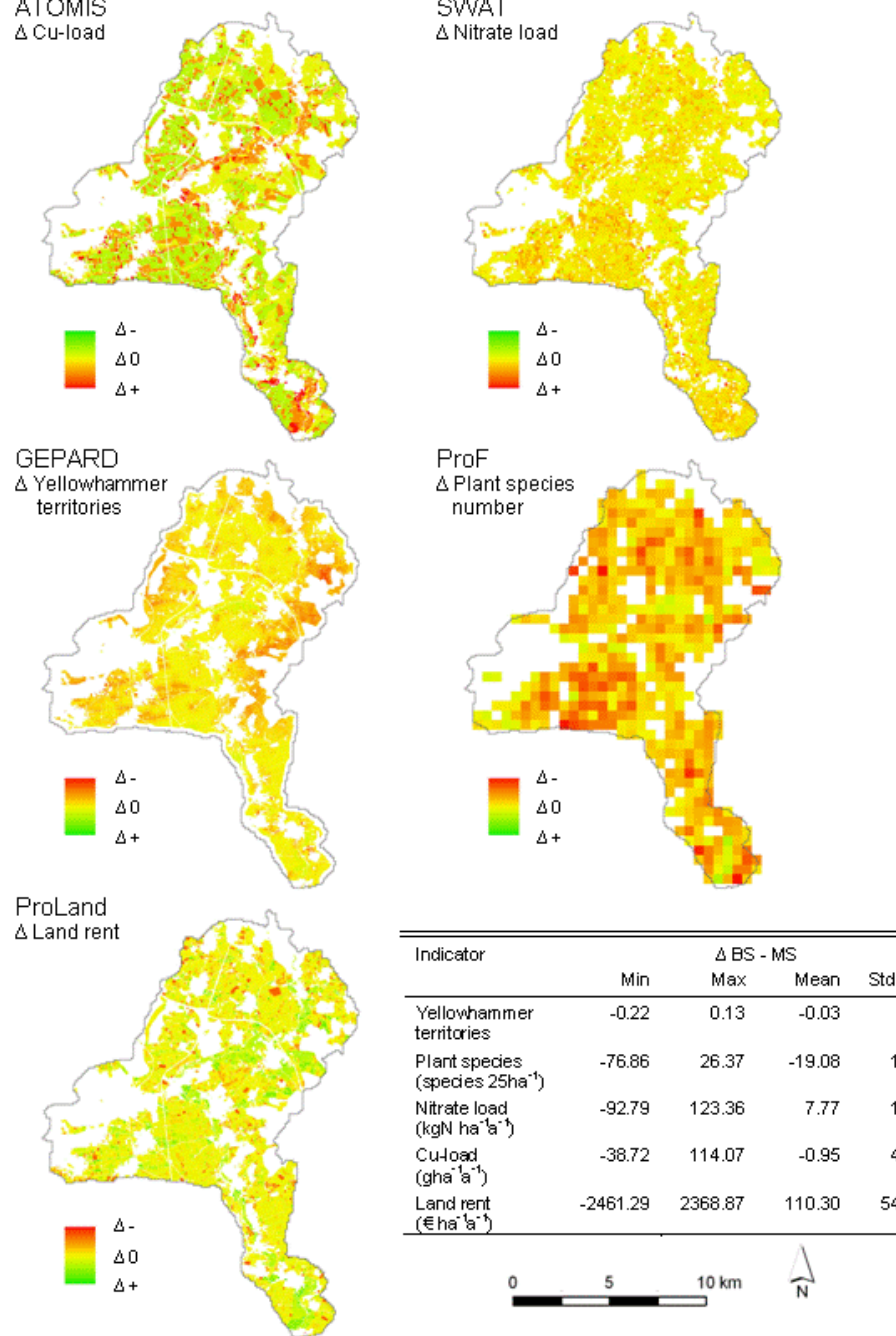
Fig. 2 . Standardized differences in indicator values as calculated for indicator-specific reference units. Standardization against min. ( D -), mean ( D 0), and max. ( D +) indicator values. Red color: functional deficits. Non-agricultural land (mainly forests and settlements) was excluded from data